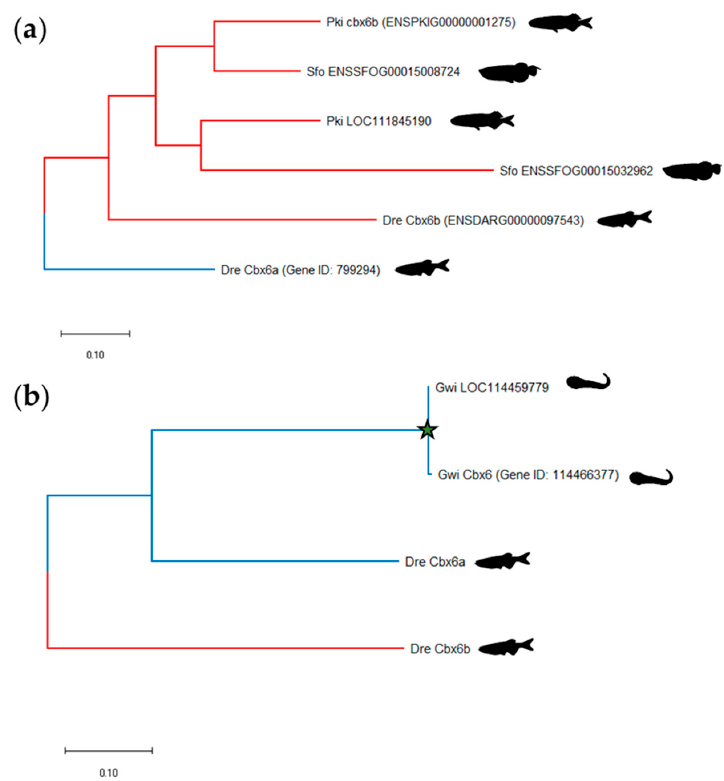
Figure 4. Phylogenetic trees of the evolutionary relationships between Cbx6 proteins from teleost fishes. ( a ) Phylogenetic tree of the evolutionary relationships between zebrafish (Dre, Danio rerio ) Cbx6a and Cbx6b proteins with their orthologues in elephant fish (Pki, Paramormyrops kingsleyae ) and Asian bonytongue (Sfo, Scleropages formosus ). ( b ) Phylogenetic tree of the evolutionary relationships between zebrafish Cbx6 proteins and their orthologues in blunt-snouted clingfish (Gwi, Gouania willdenowi ). The evolutionary history was inferred using the Neighbor-Joining method conducted in MEGA